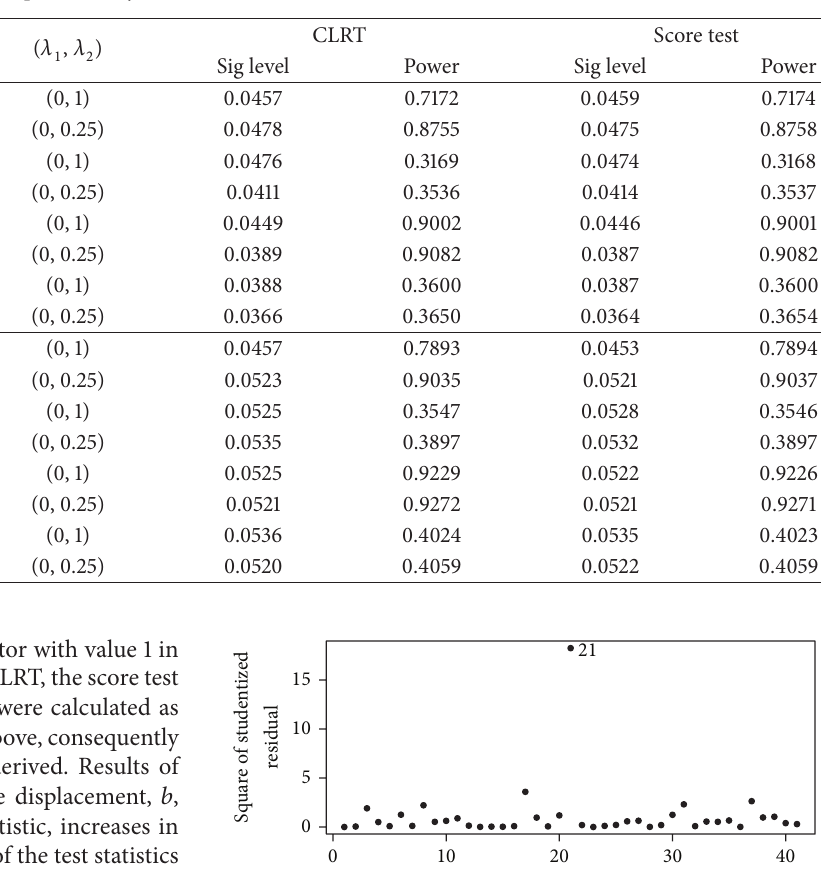
Table 3: The probability of a type Ι error ( 𝛼 = 0.05 ) and power of CLRT and score test statistics for a variance shift model in a linear measurement error with combination different of parameters 𝛽 , 𝜎 2 , Λ , and 𝑏 = 5 .